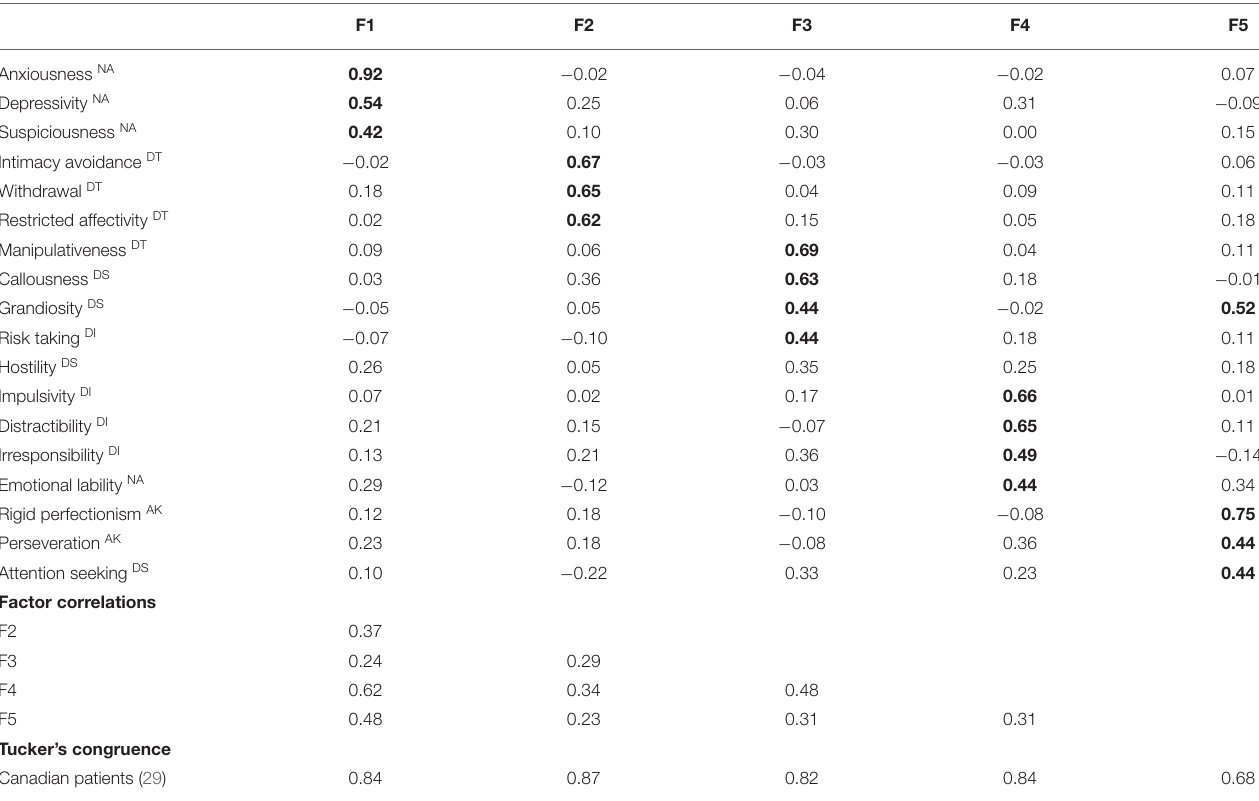
TABLE 4 | ICD-11 five-factor loadings, factor correlations, and congruence coefficients.